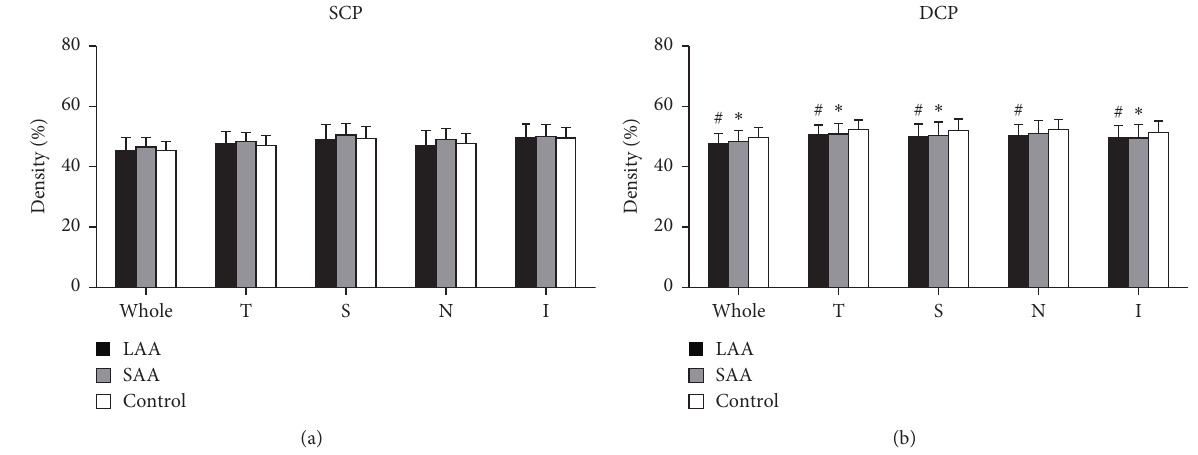
Figure 3: Comparisons of the microvascular density on OCTA images in whole and four quadrant sectors of the superficial capillary plexuses (SCP) (a) and deep capillary plexuses (DCP) (b). ∗ P < 0.05, the density in the SAA group was lower than that in the control group; # P < 0.05, the density in the LAA group was lower than that in the control group. Table 5: D box in the superficial and deep retinal capillary